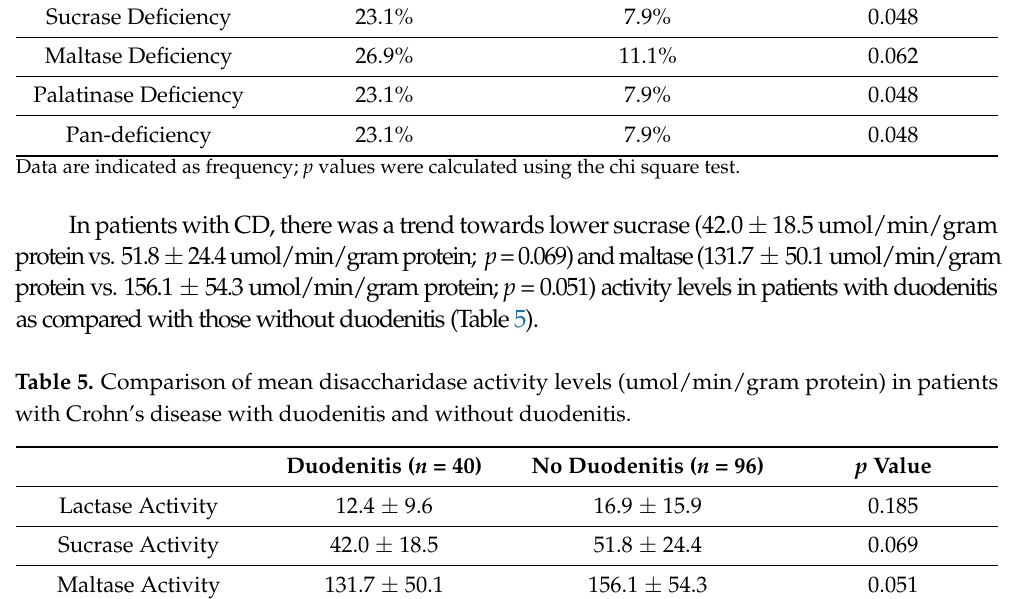
Table 4. Comparison of the frequency of disaccharidase deficiency in patients with Crohn’s disease with duodenitis vs. those without duodenitis. Duodenitis ( n = 40) No Duodenitis ( n = 96) p Value Lactase Deficiency 57.7% 55.6% 0.853 Sucrase Deficiency 23.1% Maltase Deficiency 26.9% 23.1% 23.1% 7.9% 0.048 Data are indicated as frequency; p values were calculated using the chi square test.